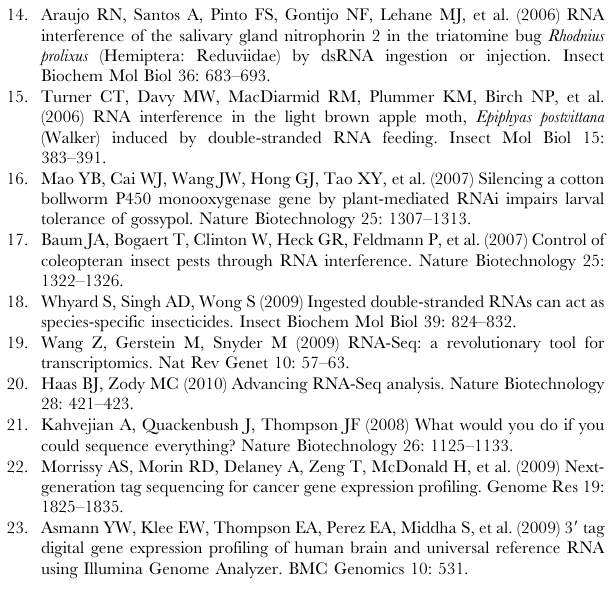
Table S1 DGE-tag mapping by RNA-seq dataset and annotated. Table S2 Larval stage high expression tags copy number confirmation by qRT-PCR.